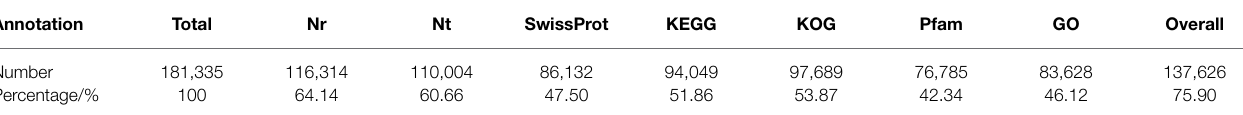
TABLE 2 | Annotation of transcripts in the NR, NT, GO, KOG, Pfam, KEGG, and SwissProt databases.